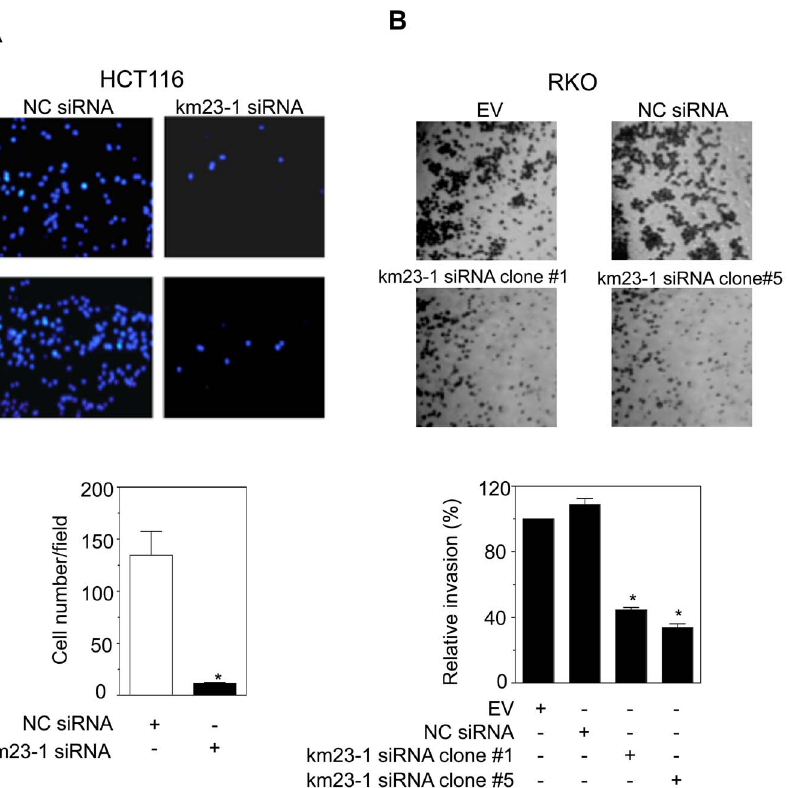
Figure 4. Depletion of km23-1 inhibits cell migration and invasion of human CRC cells. A: Transwell migration assays were performed as described in ‘‘Materials and methods.’’ Briefly, HCT116 cells stably transduced with lentiviral vectors expressing either piLenti-NC siRNA-GFP or piLenti-km23-1 siRNA-GFP were seeded into the upper wells of the Costar Transwell System (8- m m pore size polycarbonate membrane, 6.5-mm diameter), and the cells on the lower surface of the well after 24 h were fixed in methanol and stained with DAPI. Top , representative images of the lower surface of the membrane are shown (100 6 magnification). Bottom , the number of migrating cells of both NC siRNA- and km23-1-siRNA- HCT116 stable transfectants were counted under a fluorescence microscope and statistically analyzed. *p , 0.01 compared to NC siRNA. B: Matrigel invasion assays were performed with the indicated RKO stable cells clones (clones # 1, 5) for 24 h using EGF (20 ng/ml) as the stimulus as described in ‘‘Materials and methods.’’ Invaded cells were stained with 0.2% crystal violet. Top , representative images of the lower membrane surface from Matrigel are shown (100 6 magnification). Bottom , the number of invading cells for both NC siRNA and km23-1-siRNA HCT116 stable transfectants were counted under a light microscope and statistically analyzed. *p , 0.01 compared to